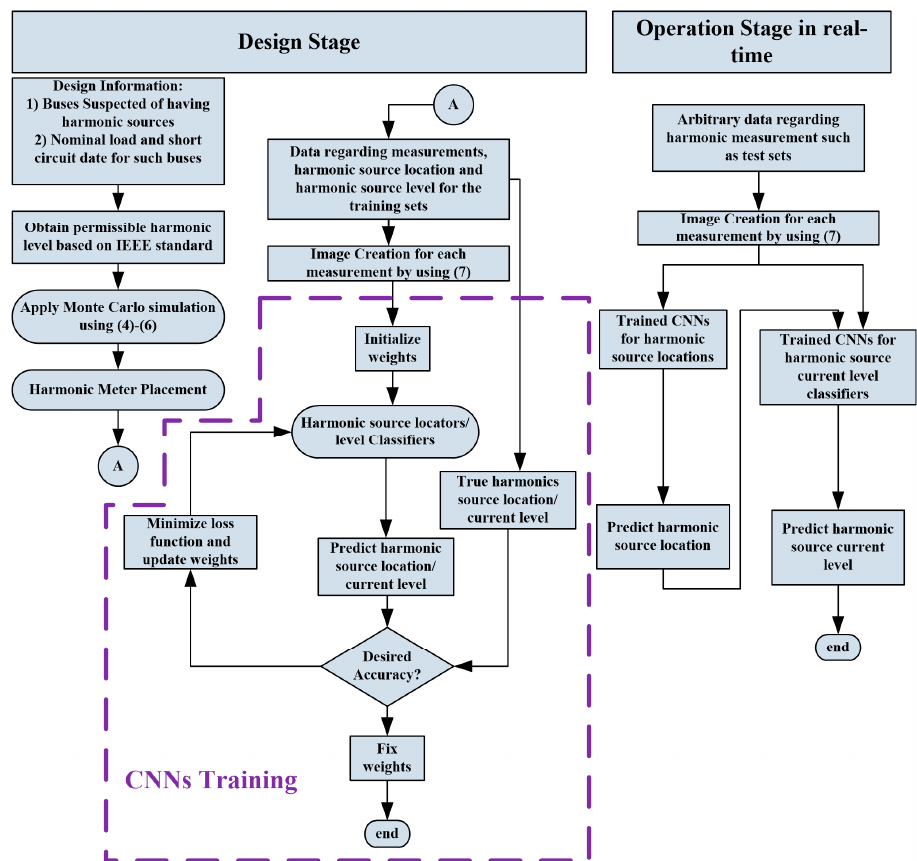
Figure 3. Flowchart of the proposed method.